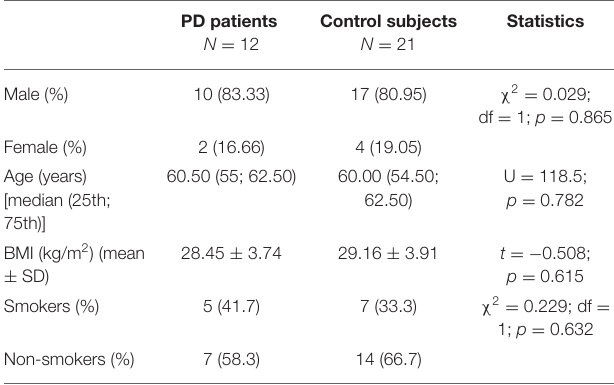
TABLE 3 | Demographic characteristics of healthy control subjects and patients with Parkinson’s disease (PD) involved in this study. PD patients N =